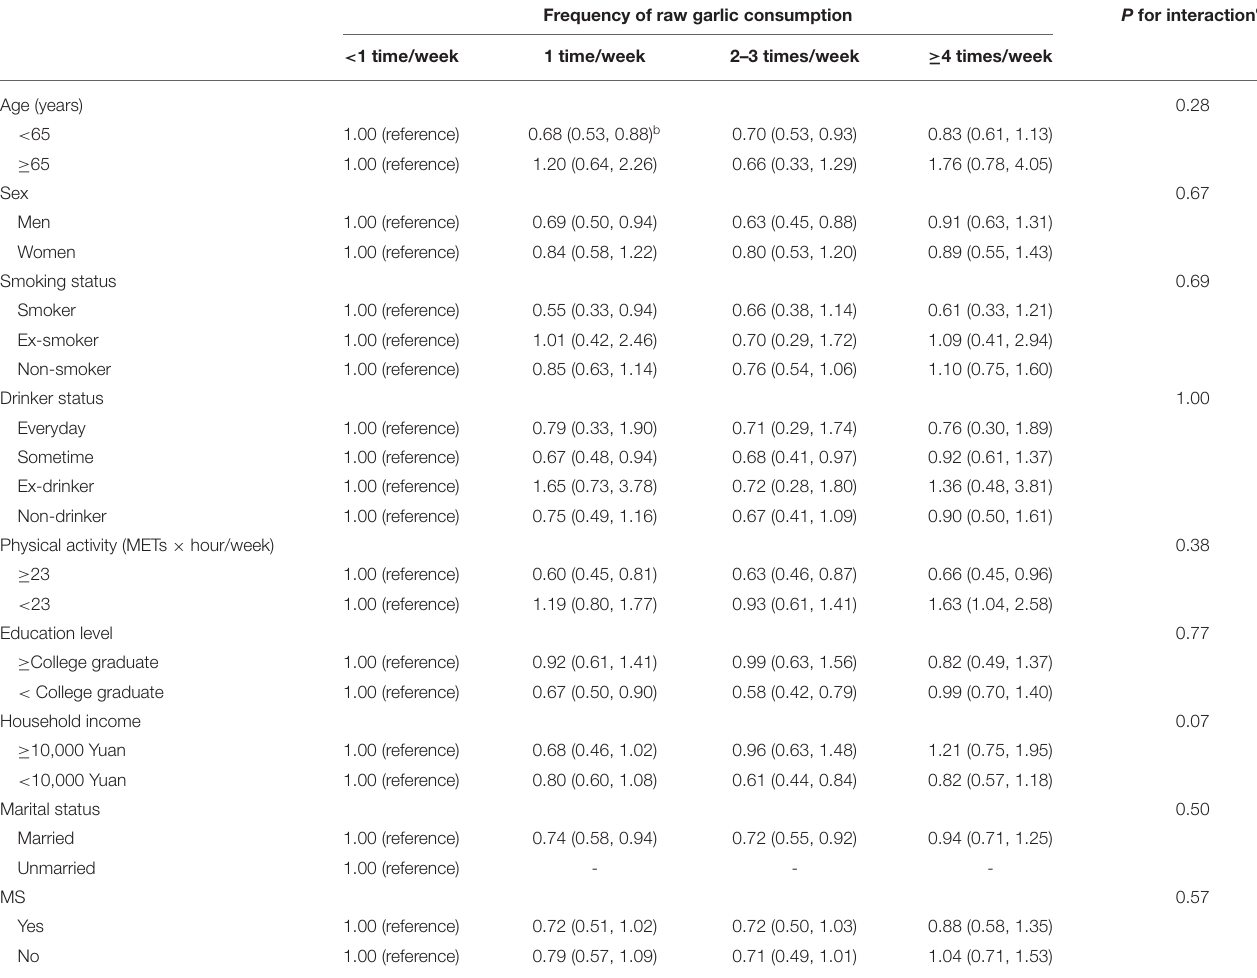
TABLE 4 | Multivariate adjusted odds ratios for thickened cIMT according to frequency of raw garlic consumption among Chinese adults stratified by major covariates a . Frequency of raw garlic consumption P for interaction